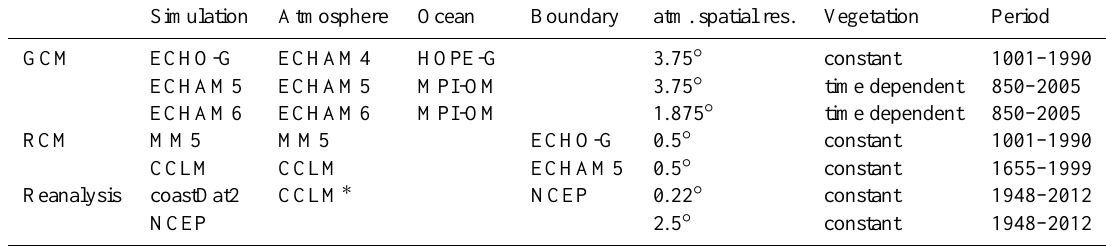
Table 1. Overview of the analysed simulations/reanalysis and their simulation acronyms, underlying atmosphere and ocean models, boundary forcings (only for regional data sets) as well as the spatial resolution of the atmosphere models and time periods, as used for the